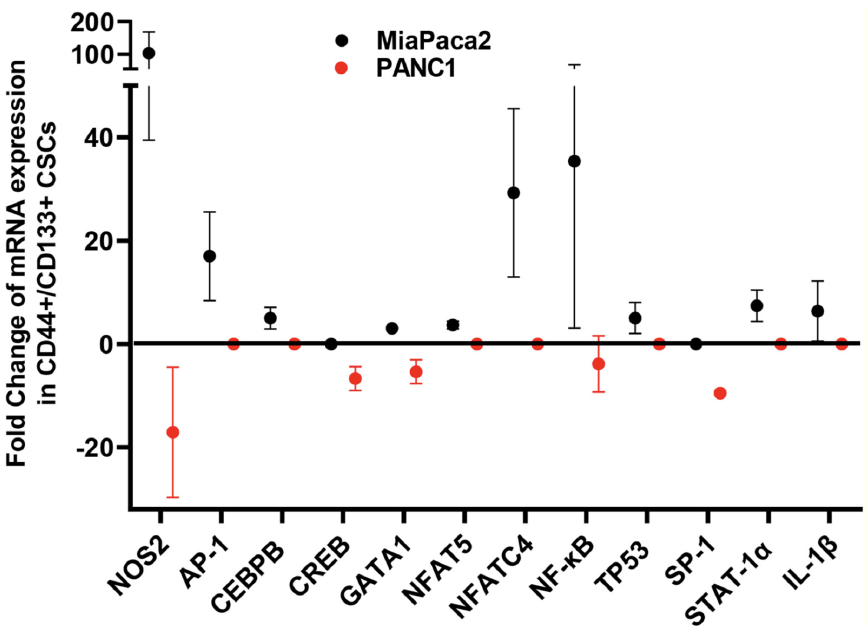
Figure 3. mRNA differential expression of iNOS and iNOS-inducing genes in CD133+/CD44+ CSCs isolated by the PDAC cell lines MiaPaca2 and PANC1. For gene microarray analysis, Agilent Array platform was employed. Quantile normalization and subsequent raw data processing were performed using the GeneSpring GX v11.5.1 software package (Agilent Technologies). Differentially expressed mRNAs between compared samples (CD44+/CD133+ vs. CD44-/CD133-) of each cell line were identified through fold change (FC) filtering (FC ≥ 2 was set as a cut-off value). Columns represent mean fold change of gene expression ± SDEV.